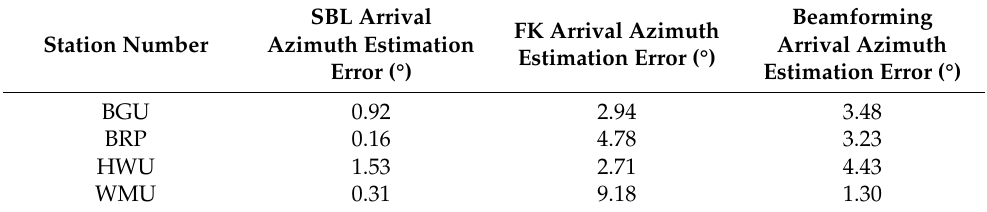
Table 4. Comparison of the error of arrival azimuth estimation between SBL algorithm, FK analysis, and beamforming